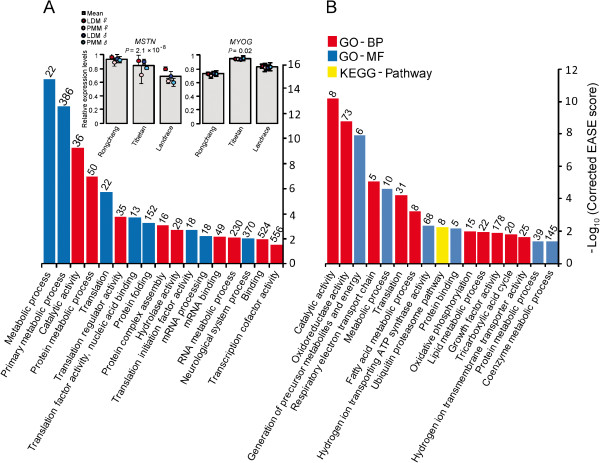
Analysis of DEGs. (A) Gene Ontology (GO) categories enriched for breed-specific DEGs and relative expression level of MSTN and MYOG genes involved in breed-specific DEGs. LDM and PMM mean longissimus dorsi muscle and psoas major muscle, respectively. Datas are means ± SD. The significance of differences among samples was determined by One-way ANOVA. (B) Gene Ontology (GO) categories enriched for tissue-specific DEGs. The EASE score, which indicated the significance of the comparison, was calculated by Benjamini-corrected modified Fisher’s exact test. BP, biological process; MF, molecular function.